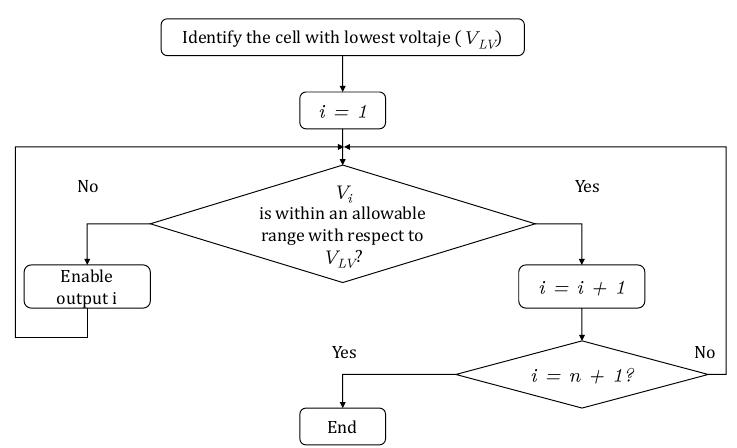
Figure 33. Algorithm for the operation of the buck-boost equalizer.